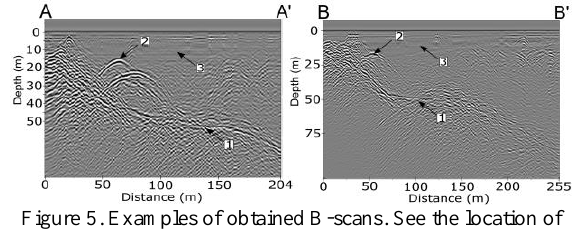
Figure 5. Examples of obtained B-scans. See the location of GPR profile lines in Fig. 7. 1 – reflection from glacier bed; 2 – reflection form englacial tunnel; 3 – radar-transparent